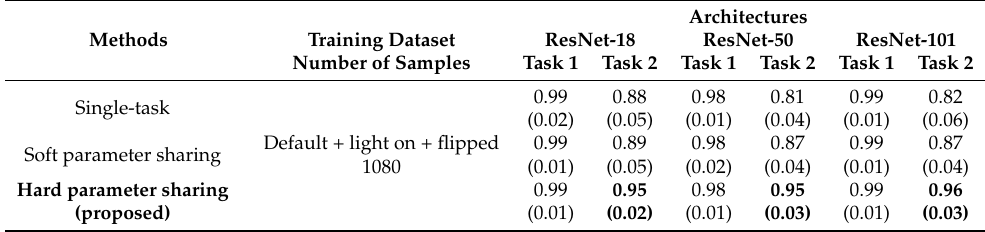
Table 10. Comparisons of results using the different methods of multi-task learning with three ResNet architectures, in terms of task-specific accuracy. The best values for each architecture are in